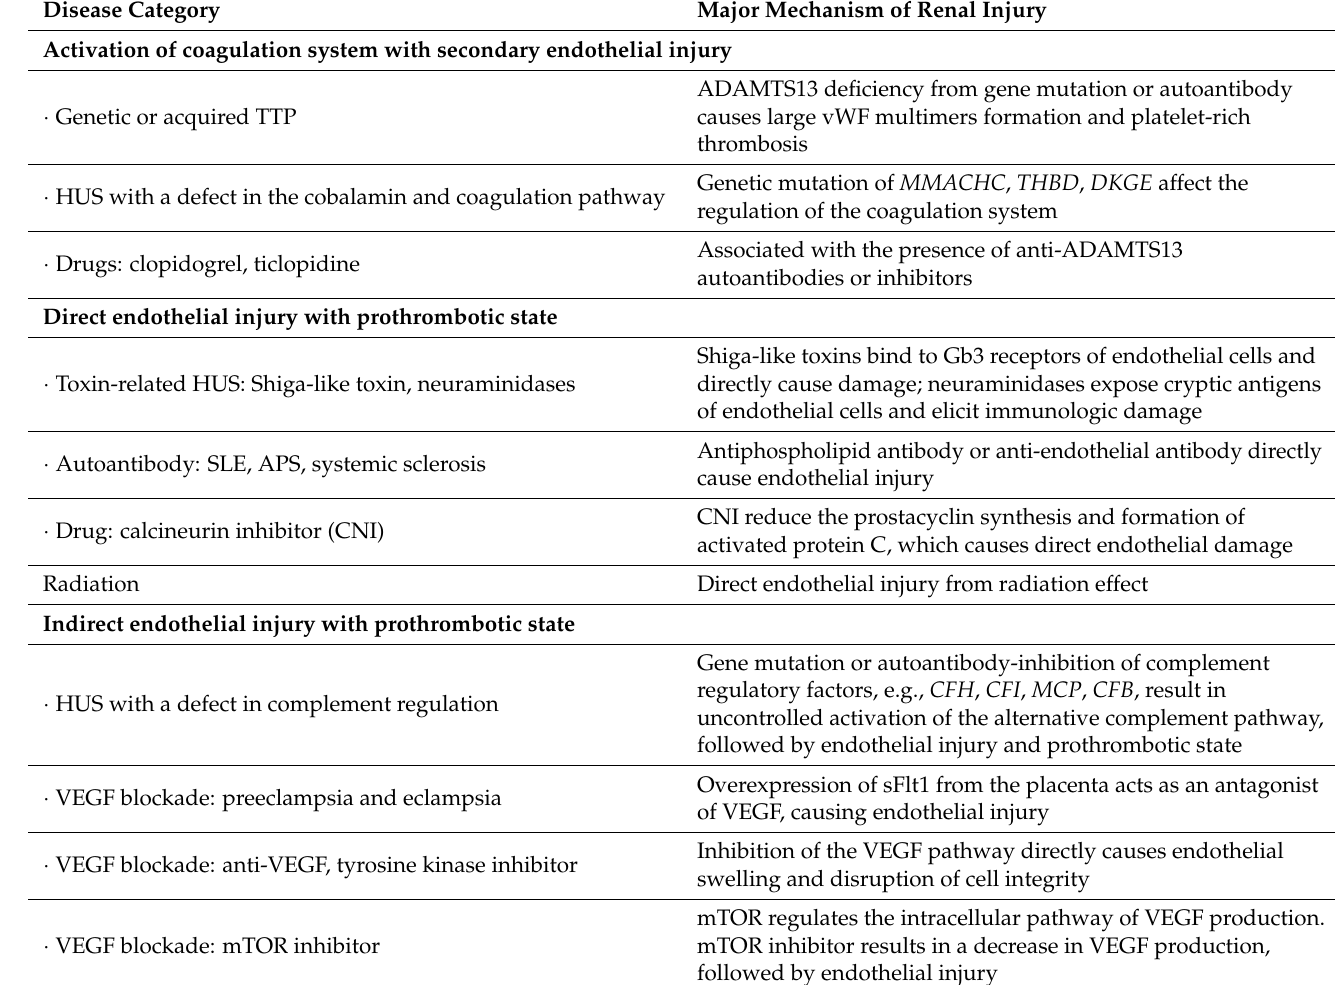
Table 2. Categories of renal thrombotic microangiopathy based on the